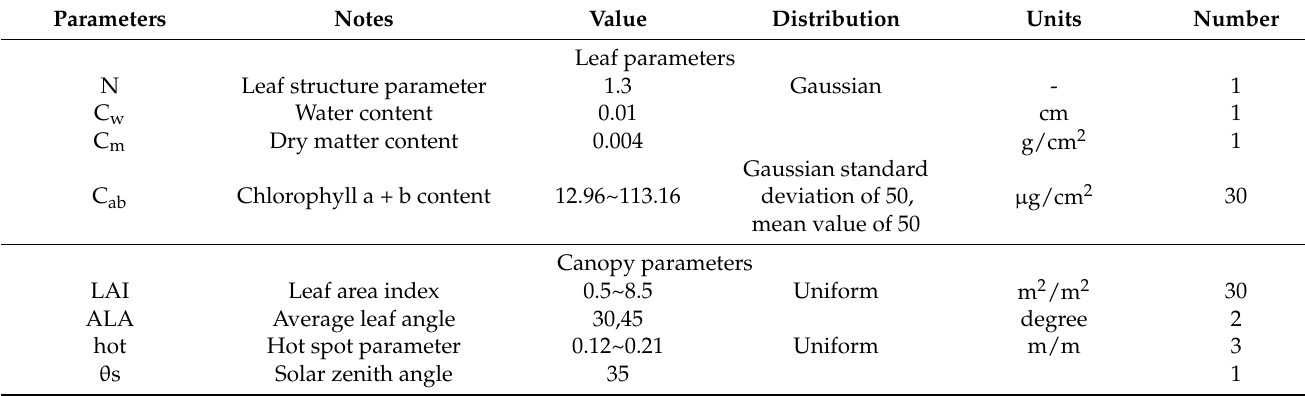
Table 2. Input parameter settings in the PROSAIL